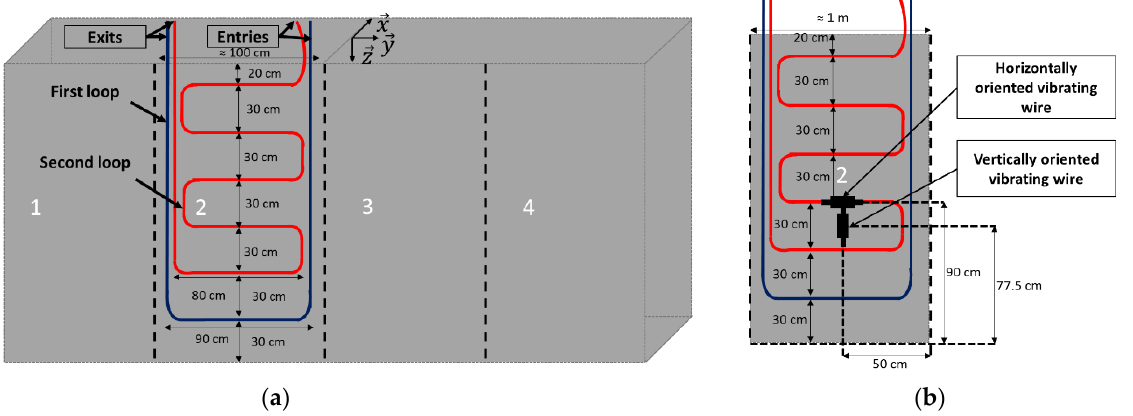
Figure 6. ( a ) Instrumentation scheme with bonded DOFS ( b ) Detail of the instrumented zone showing the two DOFS loops, and projection view of the embedded vibrating wires used for comparison.